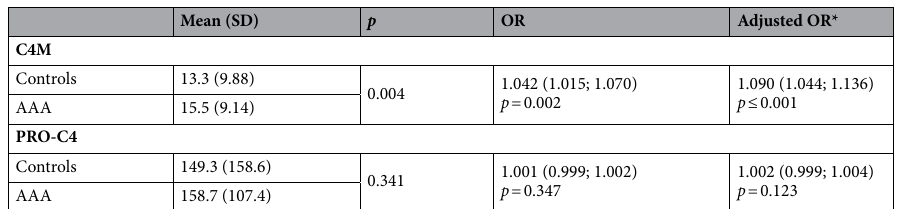
Table 2. Univariate and multiple logistic regression analyses of plasma C4M and PRO-C4 levels as independent risk factors of AAA. *Adjusted for Smoking, hypertension, previous ischemic event, statins, and diastolic blood